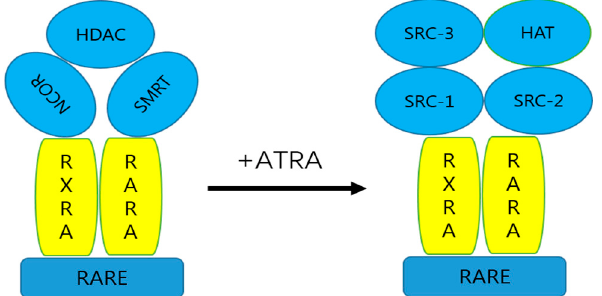
Figure 2. The genomic molecular pathway by ATRA. In the absence of ligands, retinoic acid X receptors and RXR/RAR heterodimers bind to RAREs in the regulatory regions of target genes and inhibit transcription by recruiting HDAC or silencing mediators (SMRT and NCoR). After binding to ATRA, the corepressor complex is dissociated, and the coactivator binds to histone acetyltransferase (HAT) activity, resulting in transcriptional activation of target genes.